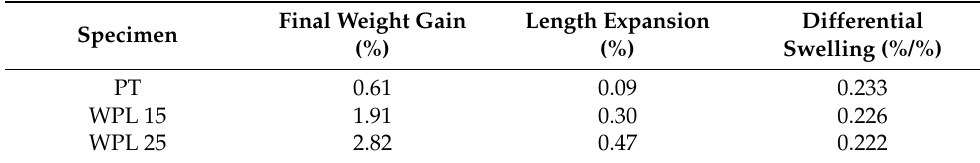
Table 1. Mean weight gain, length expansion, and differential swelling (length expansion per % of moisture change) of tested specimens after humidification cycle.